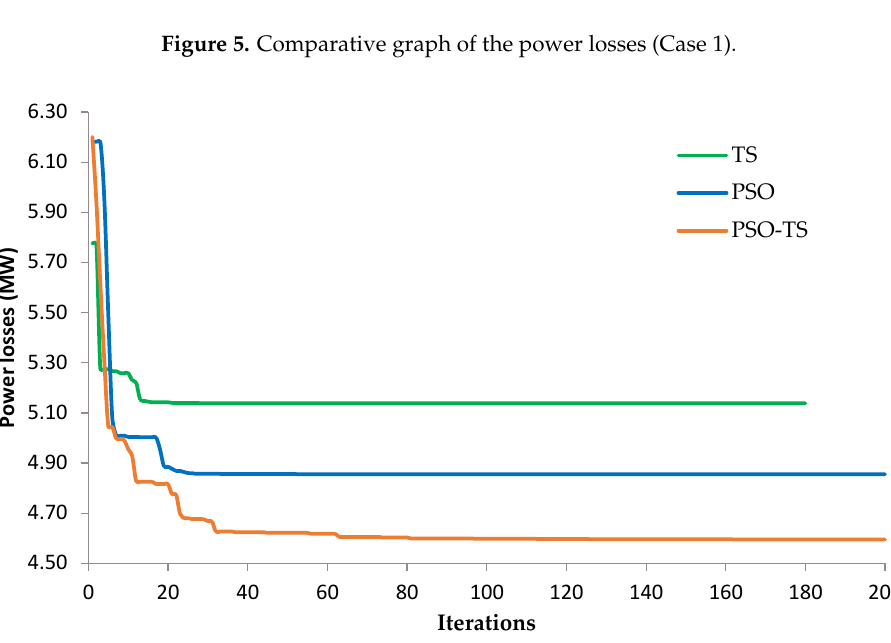
Figure 6. Convergence characteristic of the power losses (Case 1).